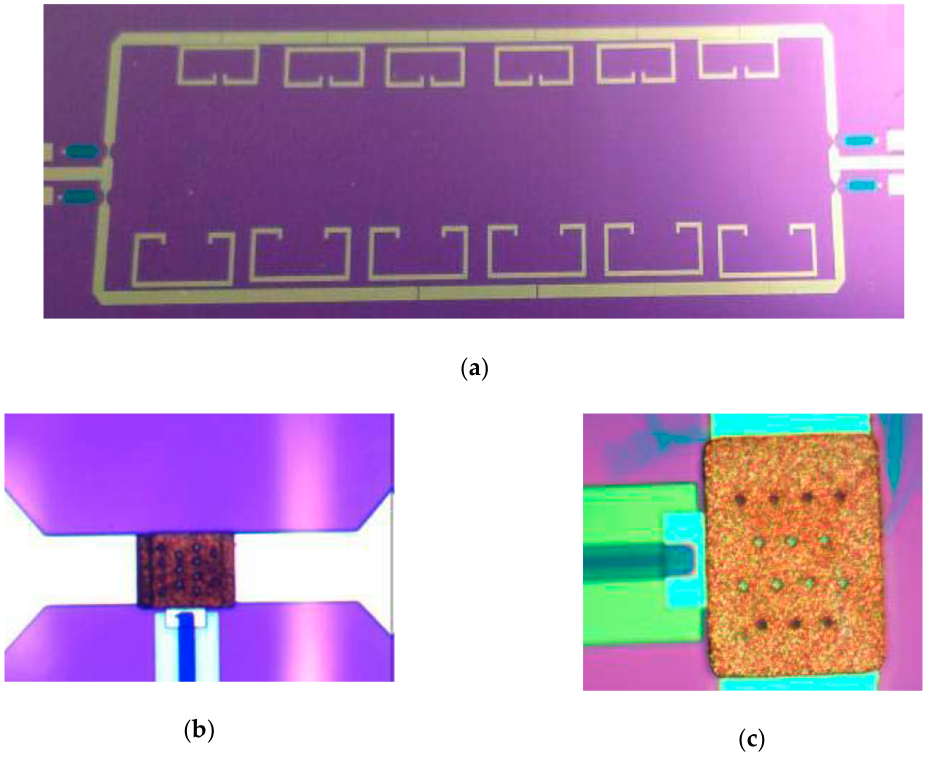
Figure 15. Design and layout: ( a ) Filter structure; ( b , c ) MEMS switch